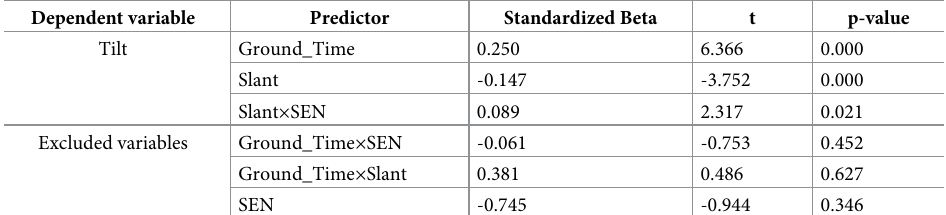
Table 10. Revised regression model of students’ Chinese handwriting tilt degree and other